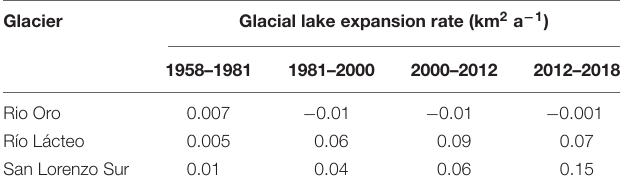
TABLE 5 | Time-interval proglacial lake growth rates. Glacier